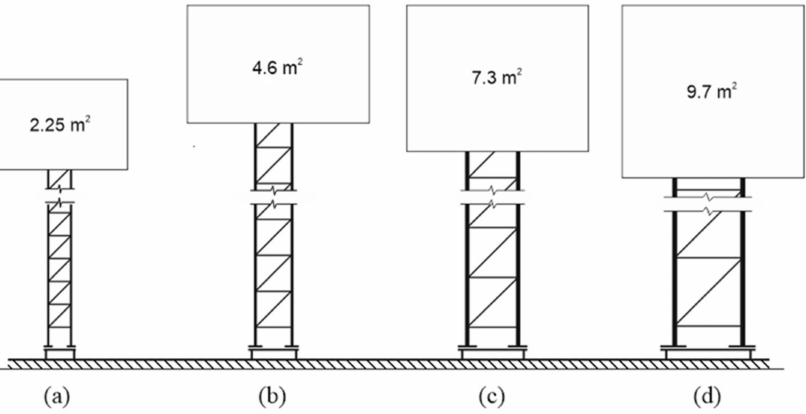
Figure 1. An outline of the product family: ( a ) mast T00, ( b ) mast T01, ( c ) mast T02, ( d ) mast T03.